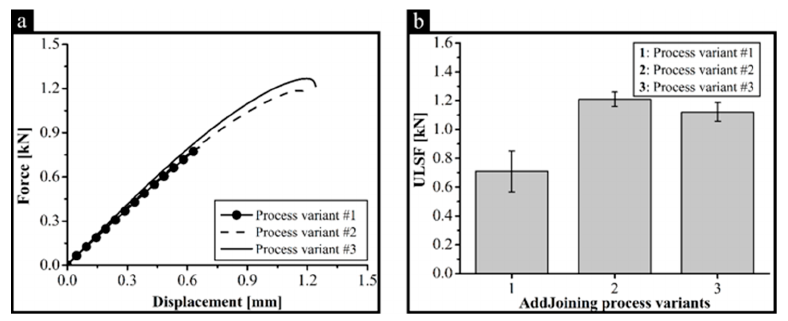
Figure 3. Mechanical performance of the AddJoining process variants: ( a ) representative force- displacement curves for process variant one (with adhesive), variant two (with heating control) and variant three (with thin-coating layer). ( b ) average ULSF for each process variant.